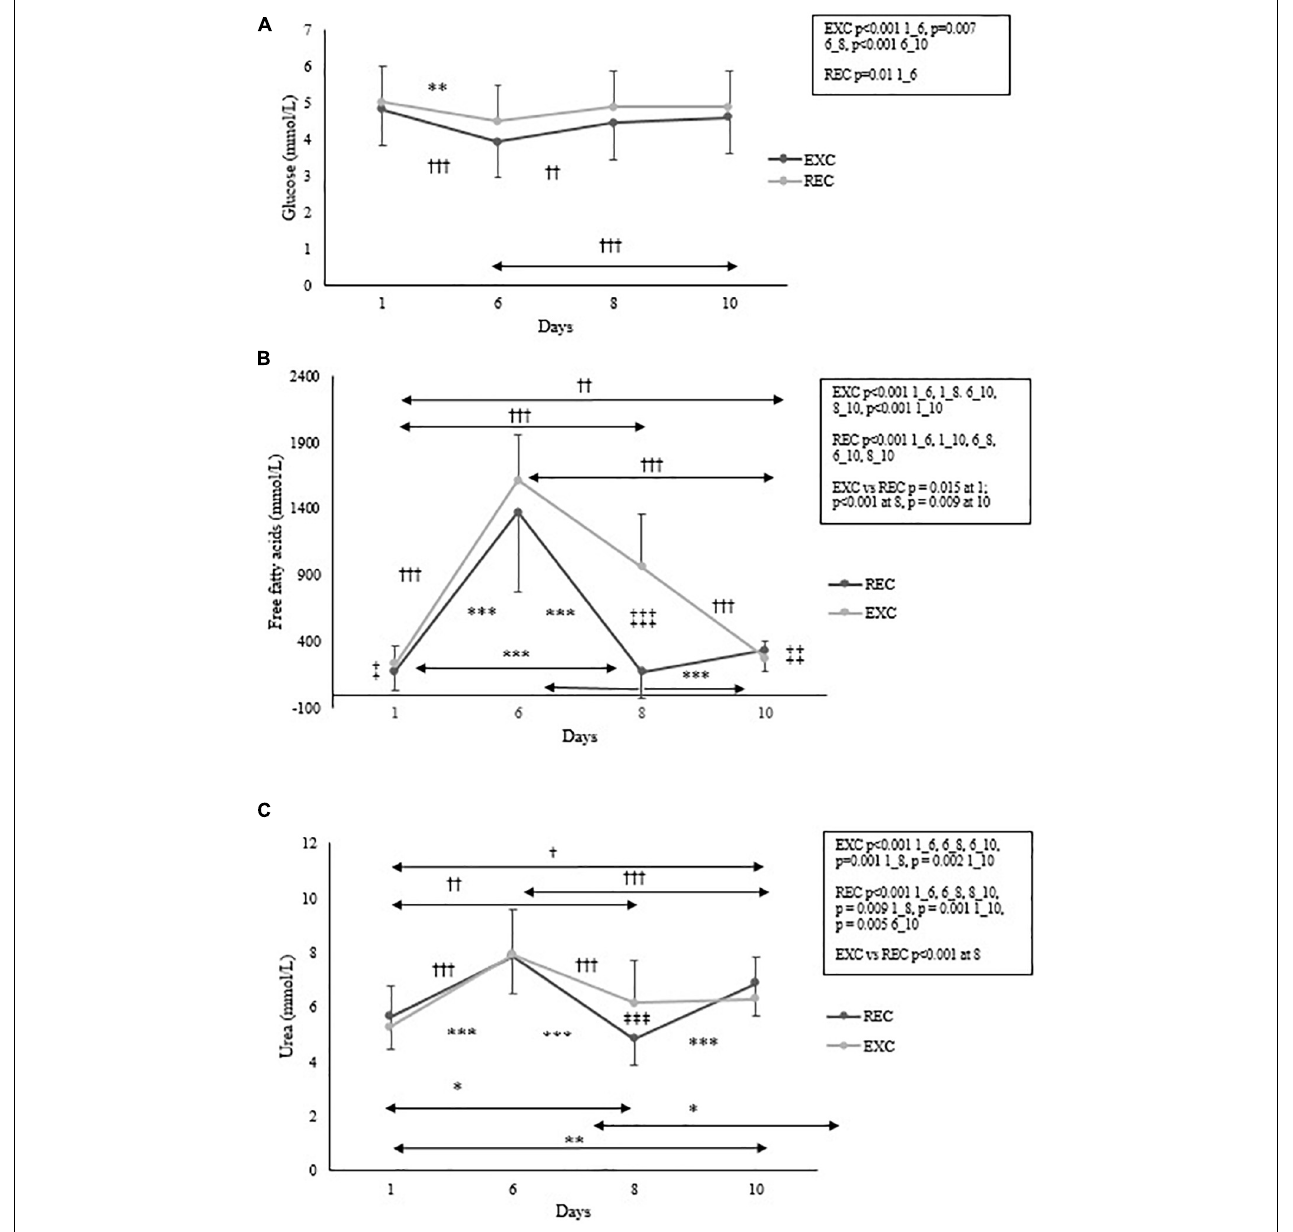
FIGURE 3 | Changes in (A) glucose, (B) free fatty acids and (C) urea concentrations within and between the REC and EXC groups. In the REC group, n = 26, 22, 22, 20 and in the EXC group n = 42, 26, 27, 25 for days 1, 6, 8, 10 respectively. ∗ REC, † EXC, and ‡ Between groups. ∗ , † , ‡ p < 0.05; ∗∗ , †† , ‡‡ p < 0.01; ∗∗∗ , ††† , ‡‡‡ p <